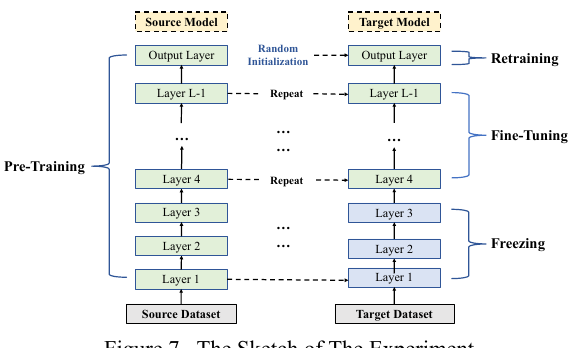
Figure 7. The Sketch of The Experiment